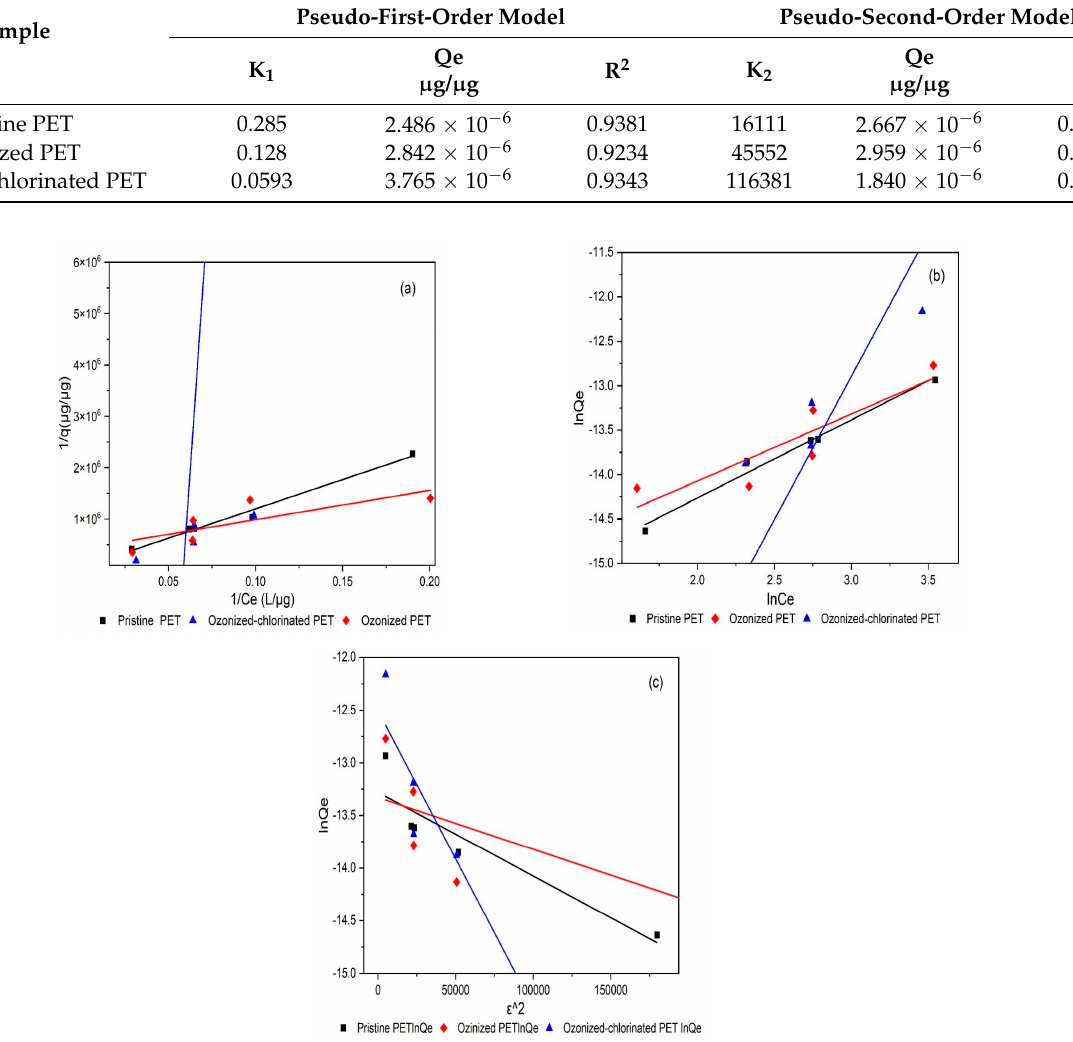
Table 2. Kinetic model parameters of pristine PET and oxidized PET.